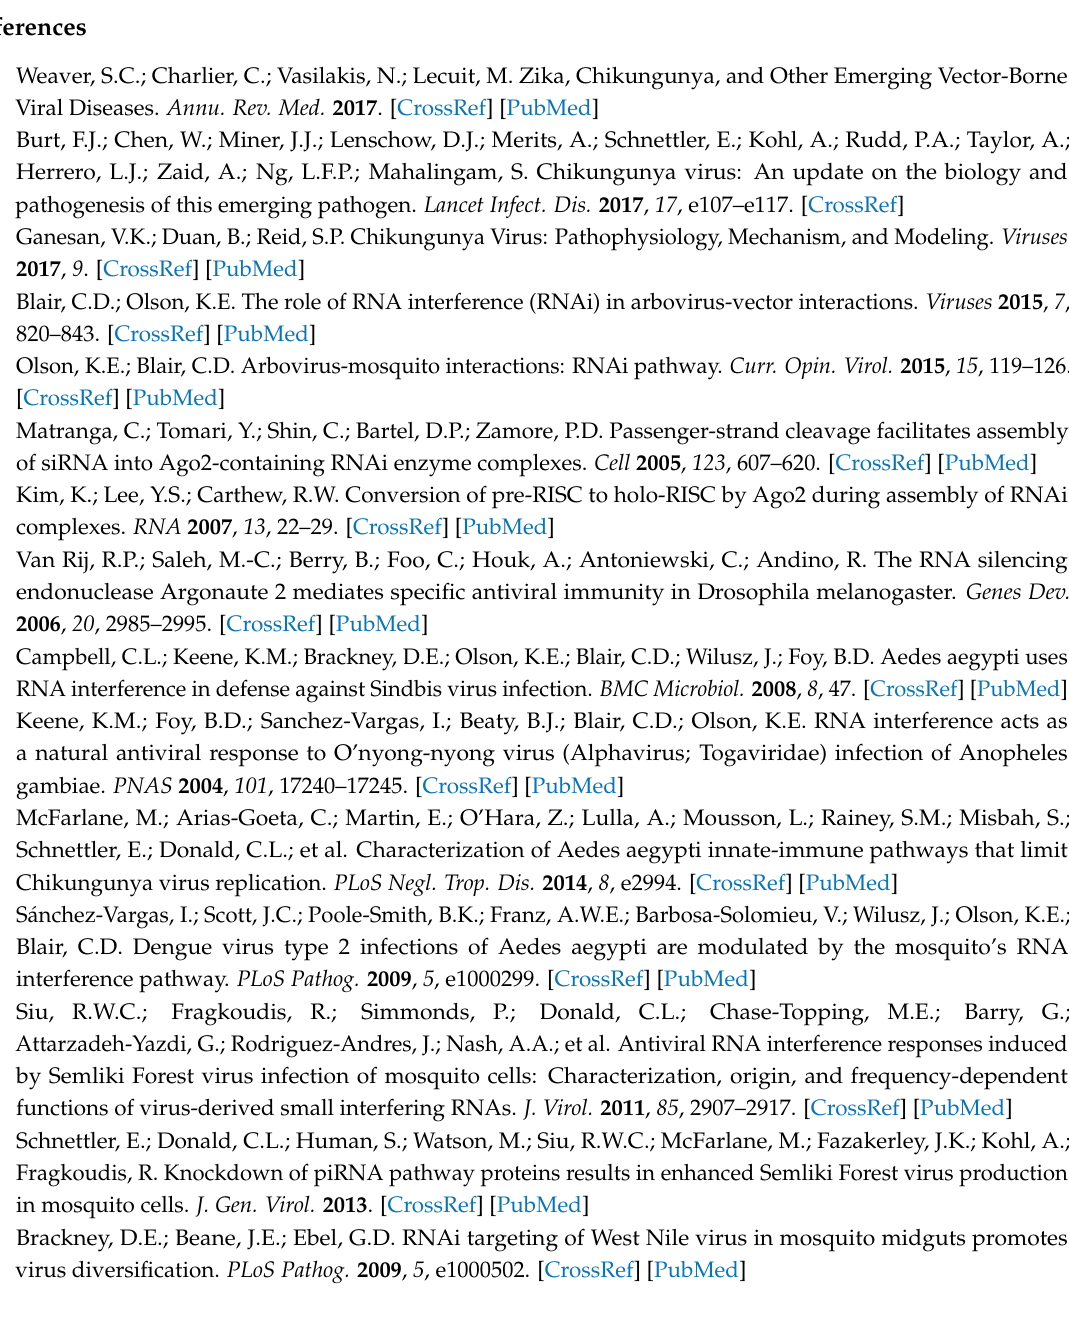
Table S1: Oligos for northern blot. Table S2: Primers sequences. Table S3: Small RNA sequencing reads. Table S4: Transposon-specific small RNA